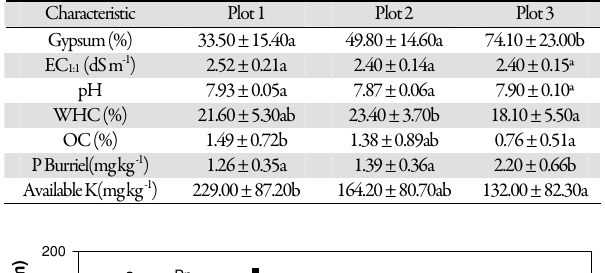
Table 1. Soil properties (mean values ± standard deviation, n = 9) of the three plots under study; values followed by the same letter do not significantly differ water extracts; WHC: water holding capacity; OC: organic carbon